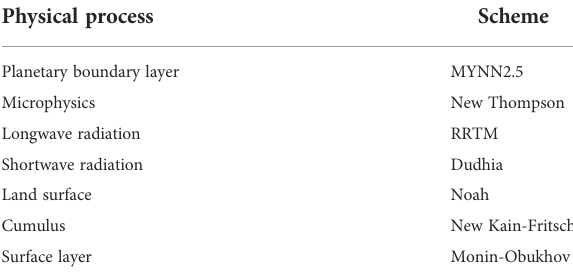
TABLE 1 Major parameterization schemes.